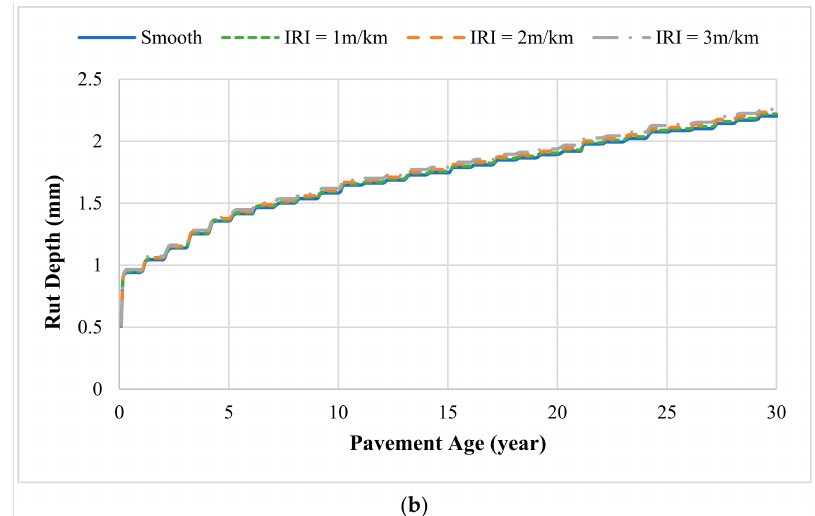
Figure 6. ( a ) Fatigue cracking (reflective); and ( b ) rut depth under the static and dynamic loads on pavement structure on major highway (10% existing cracking).